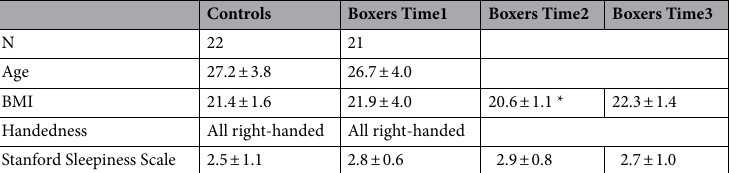
Table 1. Controls and boxers (Time1, Time2, and Time3). Controls were non-athlete male participants age-, sex-, and BMI-matched with boxers at Time1. The BMI at Time2 was significantly decreased [ F (2, 59) = 10.21, * p < 0.01] in repeated measures ANOVA. Bonferroni correction was used for the post-hoc analysis. BMI, body mass index; N, number of participants; Time1, 1 month before the match; Time2, within 1 week before the match; and Time3, 1 month after the match.